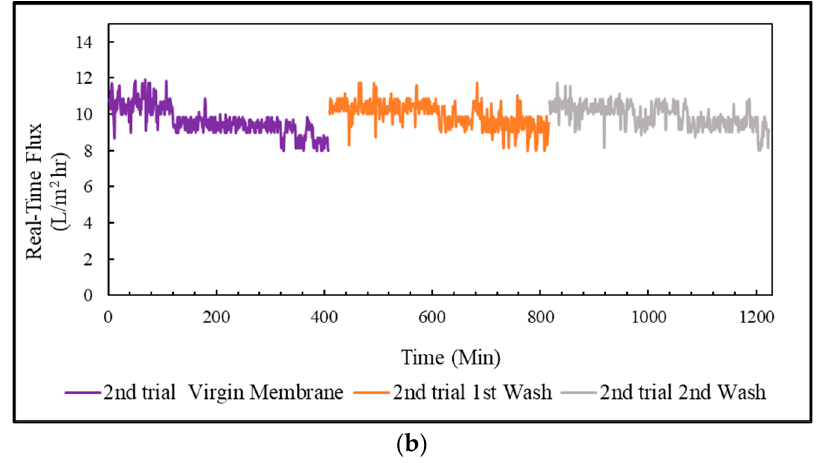
Figure 7. PSWW treatment in FO mode: ( a ) 1st trial of FO mode; ( b ) 2nd trial of FO mode.